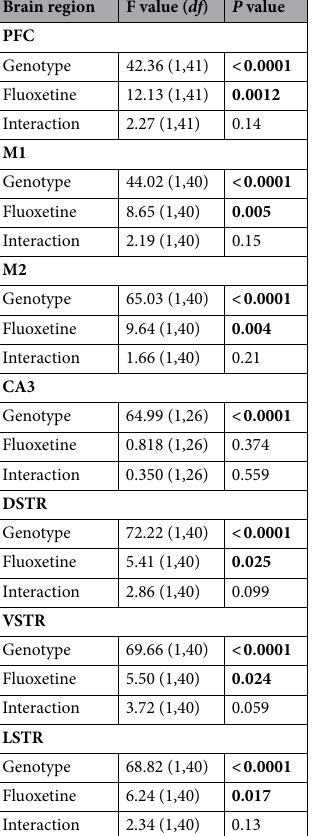
Table 1. Two-way ANOVA comparing the effect of FLX on regional MeCP2 + cells in Mecp2 HET and WT mice shown in Figs. 1 and 2. Significant effects are highlighted in bold